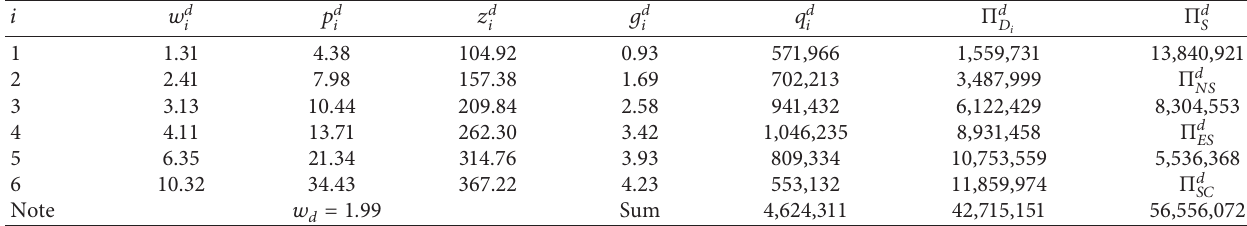
Table 6: Numerical analysis results of decentralized decision scenario with WGD effort.